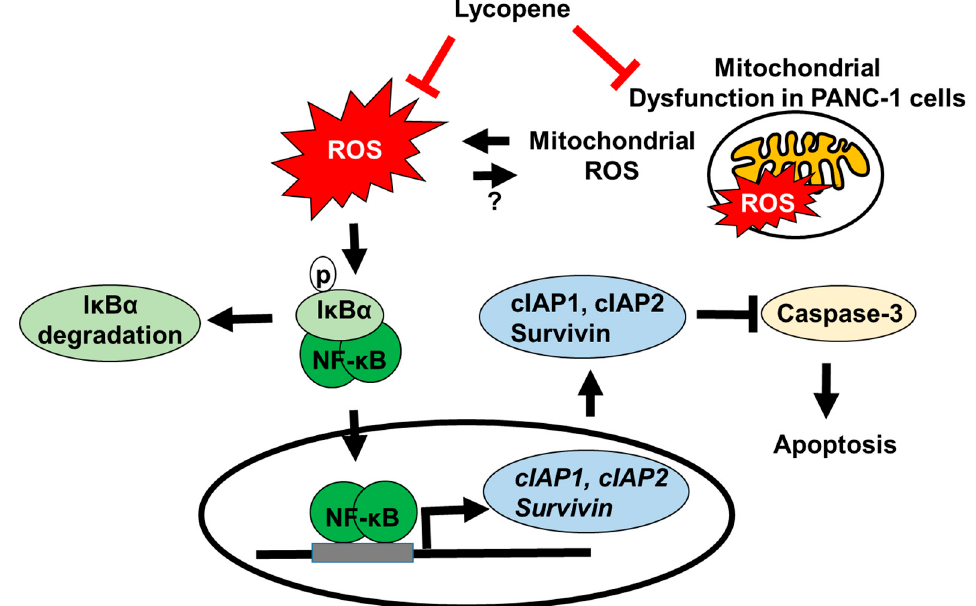
Figure 6. Schematic pathways for the inhibitory effect of lycopene on ROS-mediated NF- κ B signaling and NF- κ B target gene expression in PANC-1 cells.